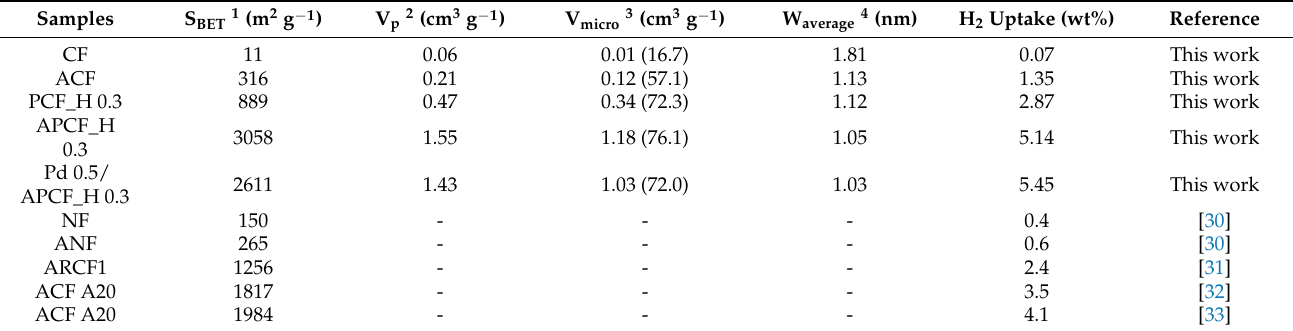
1 S BET : BET specific surface area, 2 V P : Pore volume, estimated as P/P 0 ≈ 0.99. 3 V micro : Micropore volume, determined by the Horvath – Kawazoe (HK) method; the percentage of the total pore volume constituted by mi- cropores is given in parentheses, 4 W average : Average micropore width, determined using the Saito Foley method.